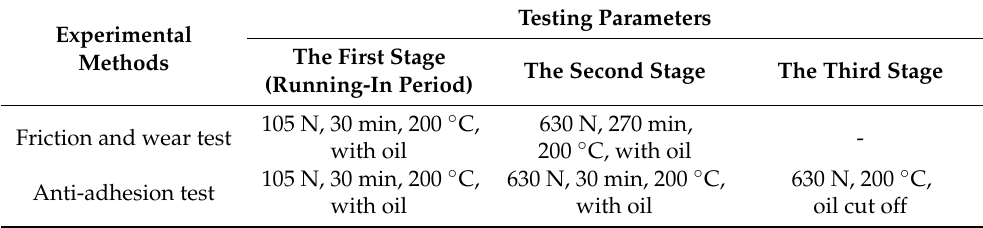
Table 2. The detailed parameters of the experimental methods at high temperature.